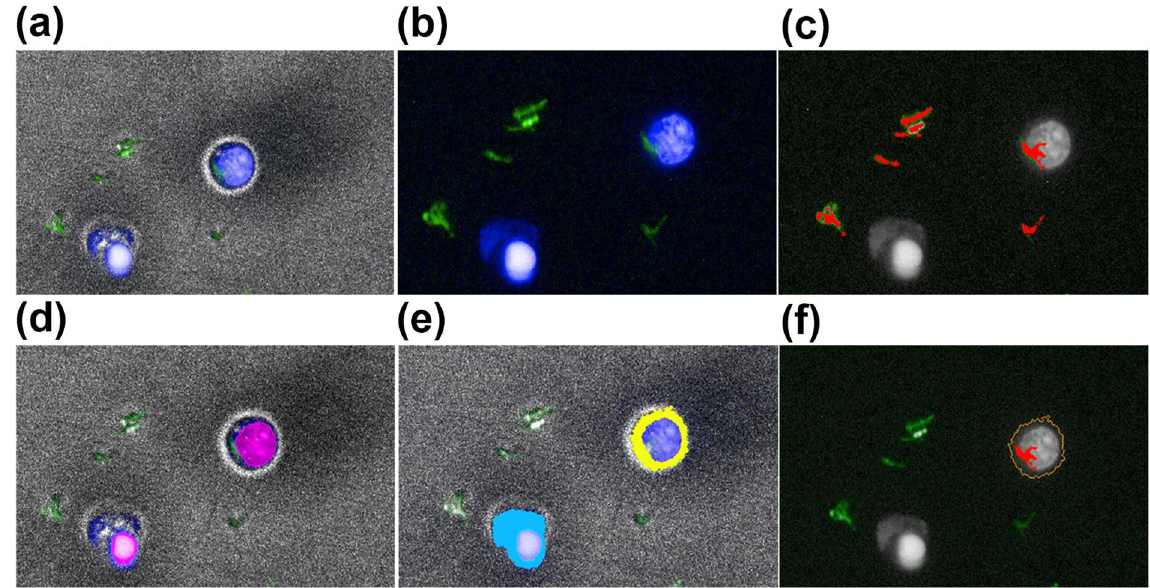
Figure 1. Automated work flow of image analysis in Harmony. THP-1 macrophages infected with GFP-H37Rv were imaged on the Operetta platform described in the Methods section. The images were subsequently analysed with Harmony software in the following work flow ( a ) Image capture from one field of view displaying brightfield (grey), Hoechst (blue), and GFP-H37Rv (green). ( b ) Image without brightfield, displaying Hoechst (blue) and GFP-H37Rv (green). ( c ) Identification of extracellular GFP-H37Rv, detected M. tuberculosis are highlighted in red, the nucleus of the macrophages is in grey. ( d ) Identification of the nucleus of macrophages, detected nuclei (pink). ( e ) Cytoplasm detection, cytoplasm in blue and yellow. ( f ) M. tuberculosis infected macrophage (outline in orange), intracellular M. tuberculosis highlighted in